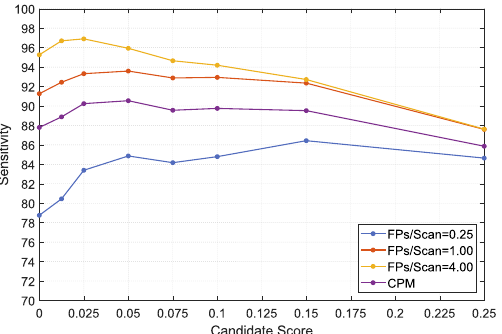
Figure 8. FROC values of the TSND using the CS-Net adopted different candidate scores on the validation set.